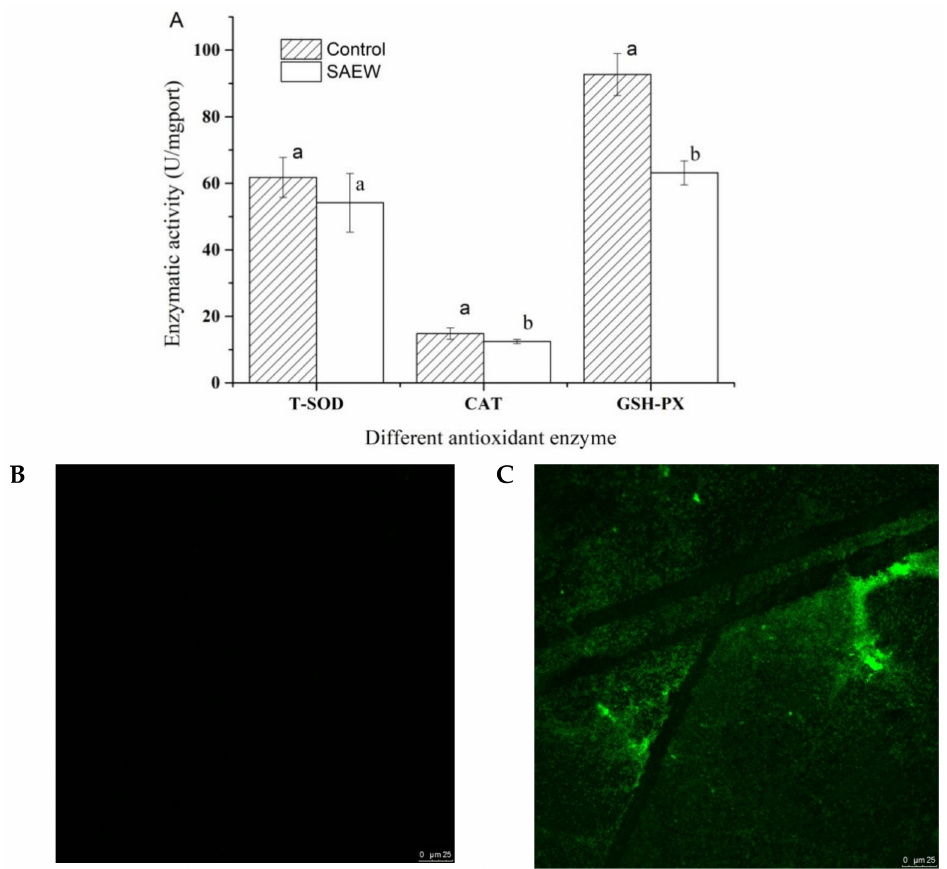
Figure 6. Effect of SAEW on antioxidant enzyme activity and ROS of L. monocytogenes . ( A ) Changes in the activity of three antioxidant enzymes including SOD, CAT and GSH-PX. Different letters on the top of the bar mean significant difference between different samples ( p < 0.05), ( B ) LSCM image of control, ( C ) LSCM image of SAEW treatment. SAEW with ACC of 6.03 ± 0.13 and pH of 5.76 ± 0.03 was used for 60 s in the experiment.( SAEW, slightly acidic electrolyzed water; ACC, available chlorine concentration; CAT, catalase; GSH-PX, glutathione peroxidase; ROS, reactive oxygen species; LSCM, scanning confocal